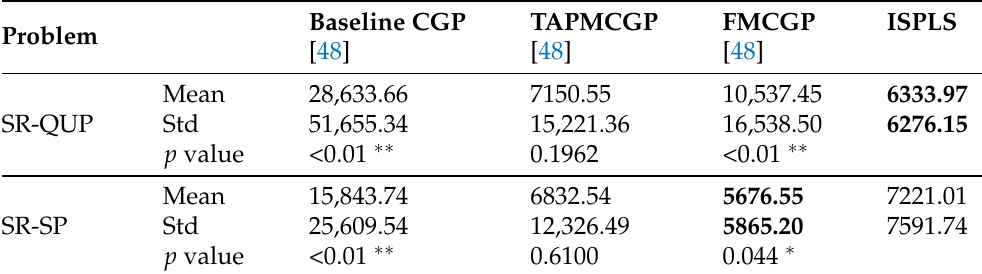
Table 6. Comparison of CGP, TAPMCGP, FMCGP and ISPLS algorithms, in terms of mean and Std, where p > 0.05 means “not significantly different”, p < 0.05 ∗ means “significantly different”, and p < 0.01 ∗∗ means “highly